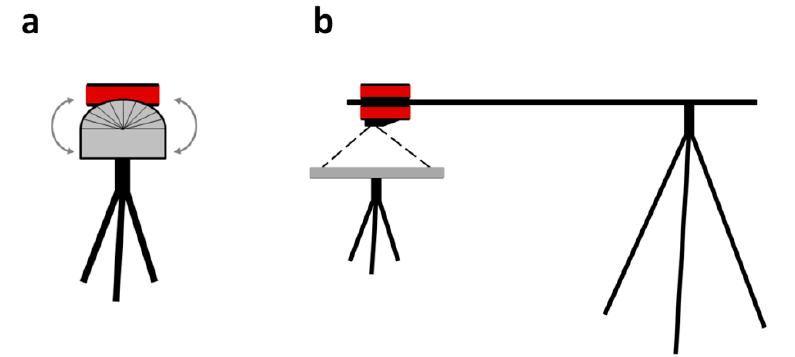
Figure 1. Set-up for the experiments with the Sequoia camera and sunshine sensor mounted on a tripod. In ( a ), the sunshine sensor was mounted on a stand where the orientation was changed in 5° intervals around one axis and compared to a fixed photosynthetic active radiation (PAR) sensor. In ( b ), the camera was facing down over a 5% reflectance calibration panel to study the influence of sensor temperature on the sensitivity of the camera.